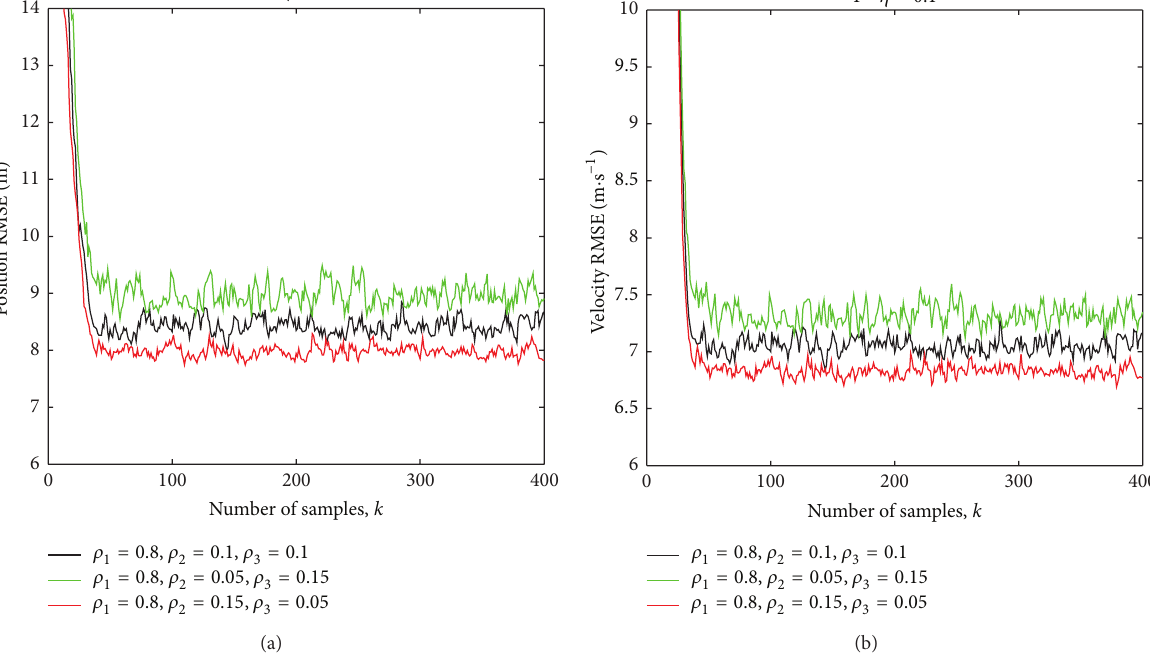
Number of samples, k